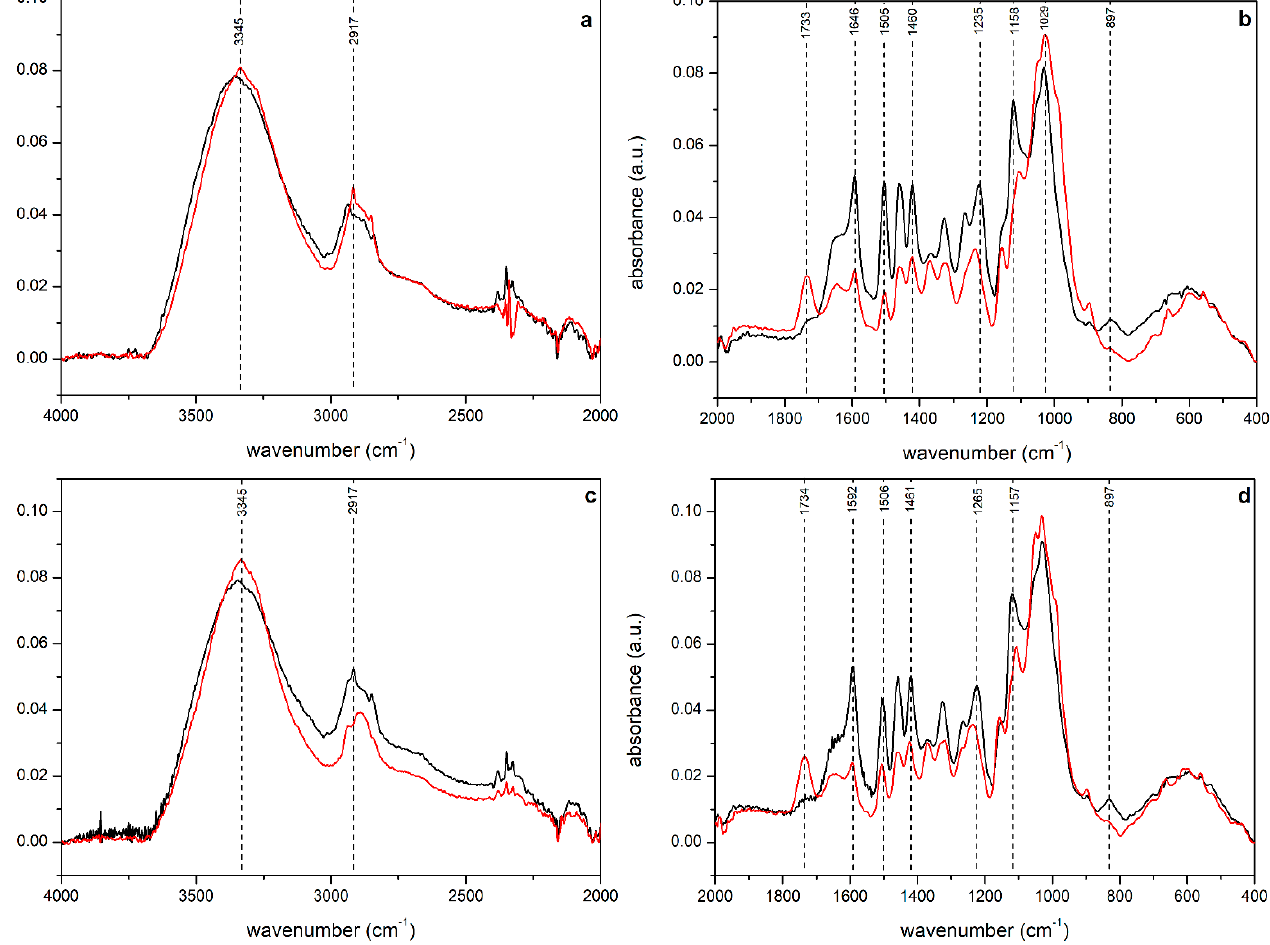
Figure 2. Fourier-transform infrared spectroscopy (FTIR) spectra of recently cut and archaeological elm ( a , b ) and poplar ( c , d ) in the region of 4000–2000 cm − 1 and 2000–400 cm − 1 . Red lines are for recently cut samples and black lines are for archaeological samples.